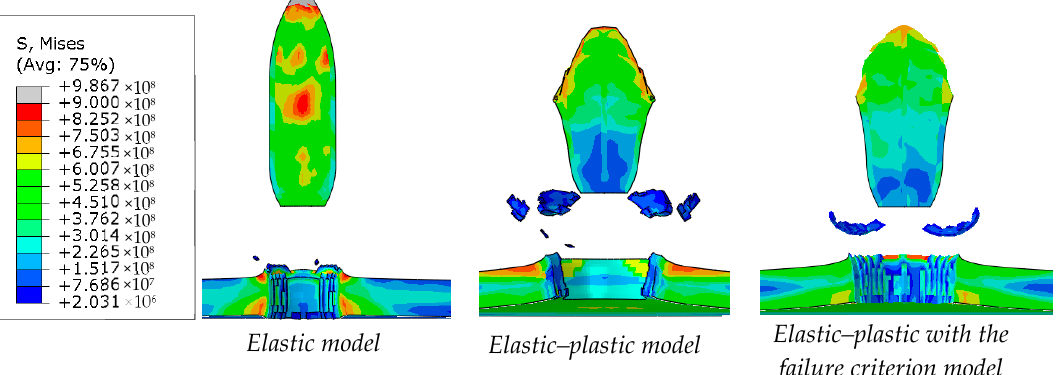
Figure 4. The shape of the projectile and the morphology of the penetration of the sample depending on the used projectile model for a sample with a thickness of 4 mm.